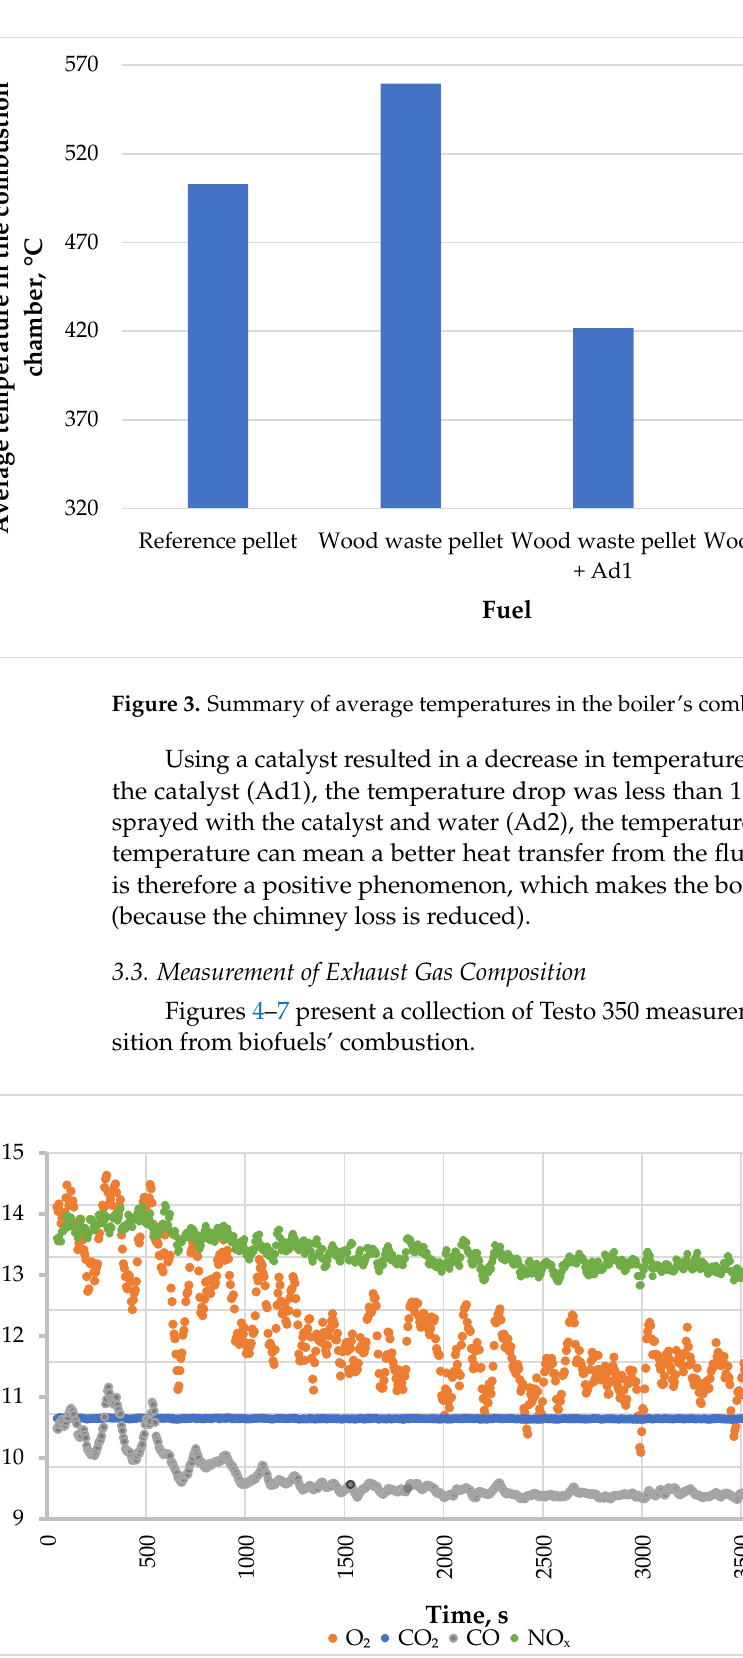
Figure 4. Chemical composition of flue gases during the combustion of the reference pellet.